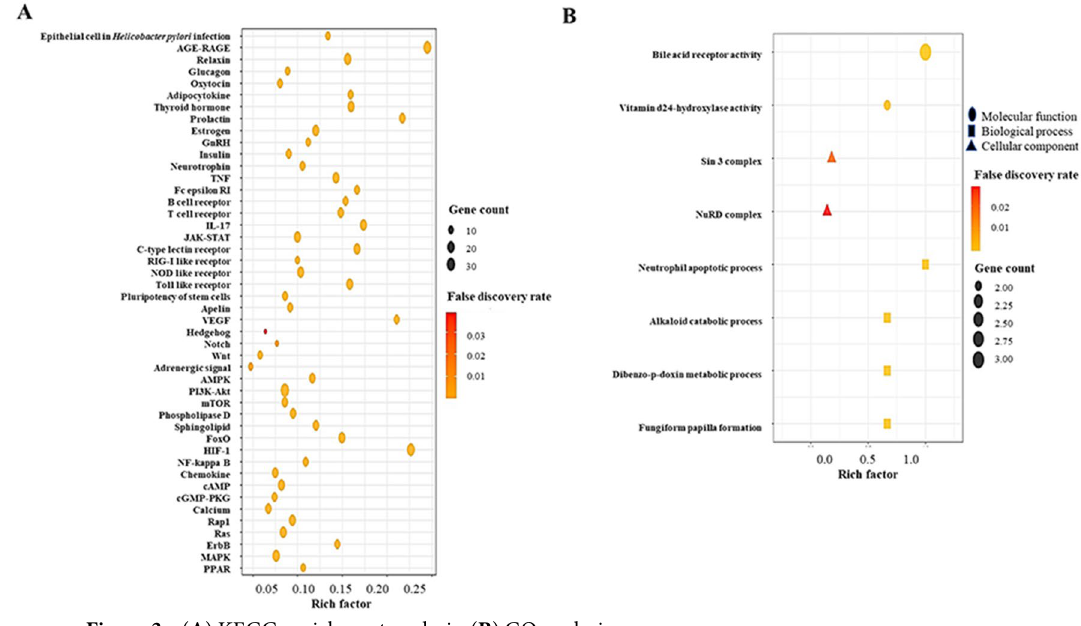
Figure 3. ( A ) KEGG enrichment analysis. ( B ) GO analysis.